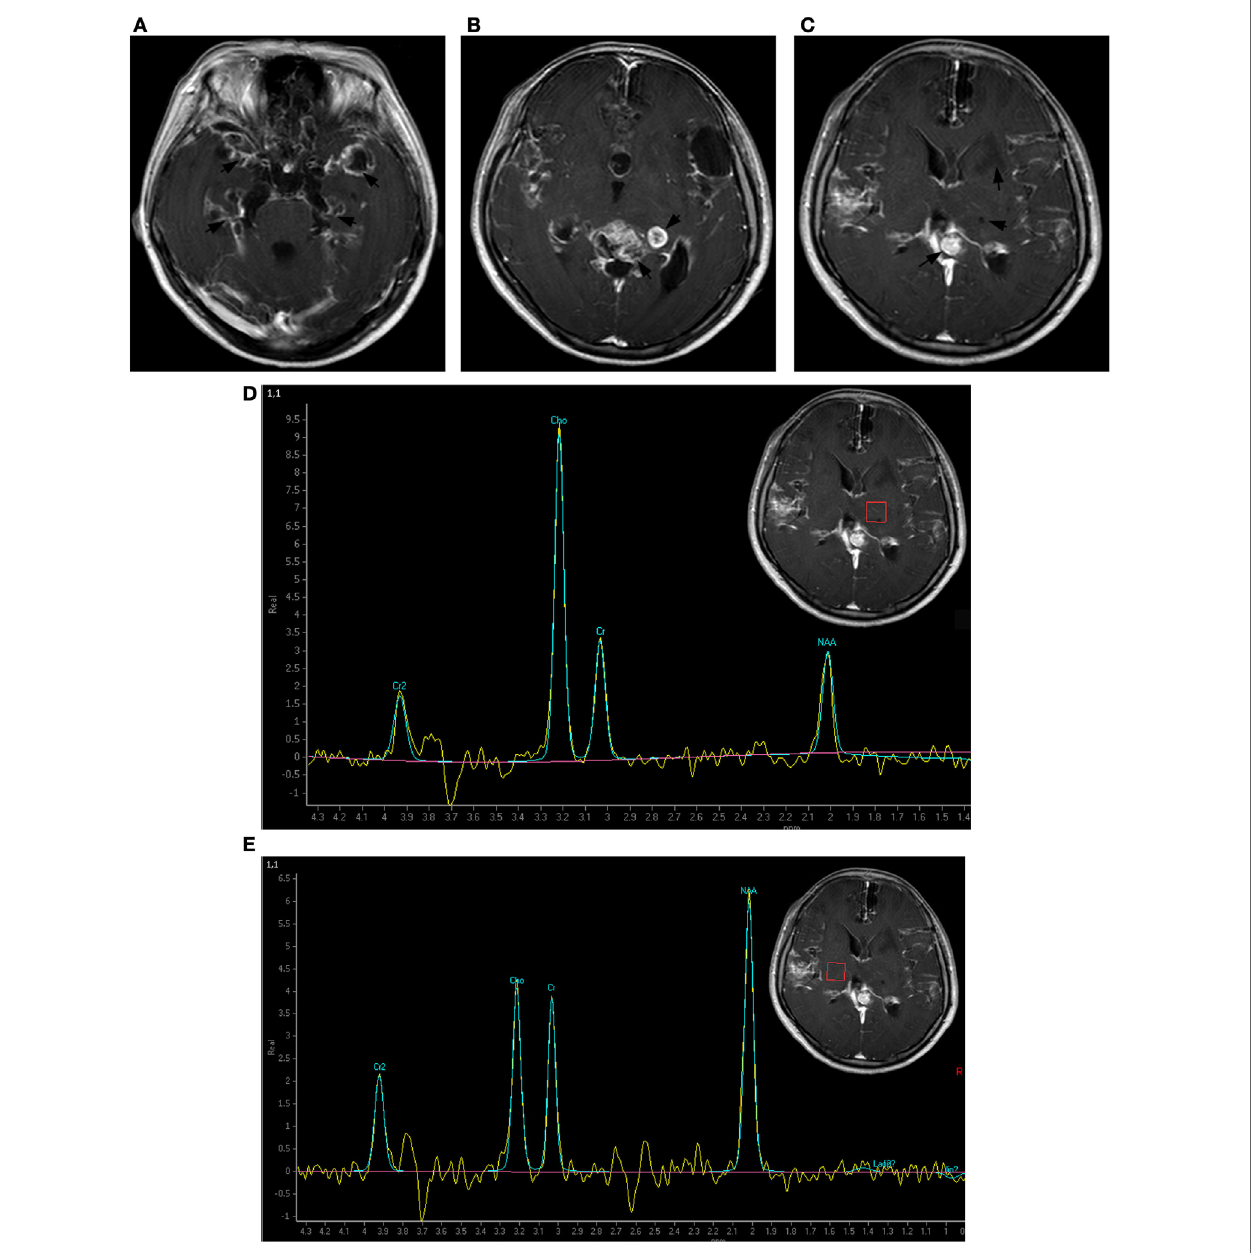
FIGURe 3 | Brain magnetic resonance imaging 1 year after symptoms onset. The subarachnoid space was markedly enlarged. More contrasted cyst-like lesions were present in the Sylvian fissure, the dilated cortex, and the left basal ganglia area and a new non-contrasted solid lesion appeared in the left paraventricular white matter. The previous left thalamus lesion was consistently unenhanced (a–C) . Magnetic resonance spectroscopy indicated a Cho/Cr wave ratio higher than 2.5 in the left thalamus and basal ganglia area (D) , and approximately 1.0 in the contralateral symmetric area (e)